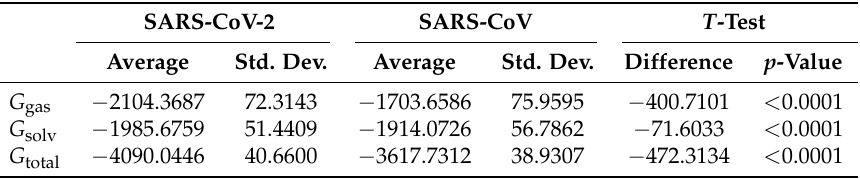
Table 3. The free energies calculated from MD simulations for the RBD proteins of SARS-CoV-2 and SARS-CoV, where G gas is the interaction energy in the gas and G solv is the solvation energy in the solvent, respectively. All units are reported in kcal/mol. The t -test was conducted to check the statistical significance of the difference between two sets of free energies. A p -value of < 0.05 indicates that the difference is statistically significant (95% confidence